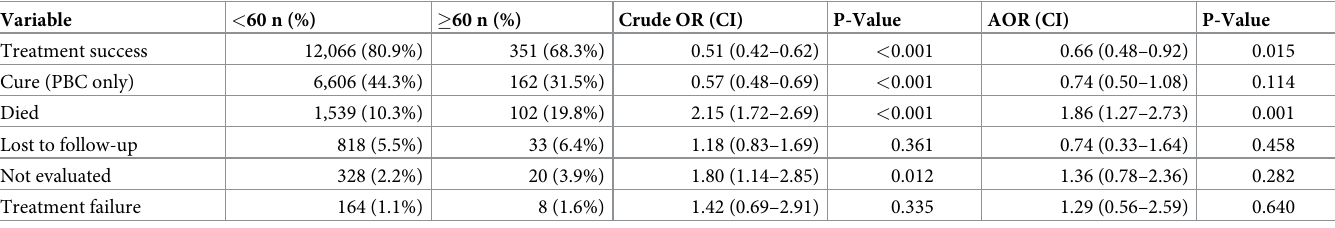
Lost to follow-up Not